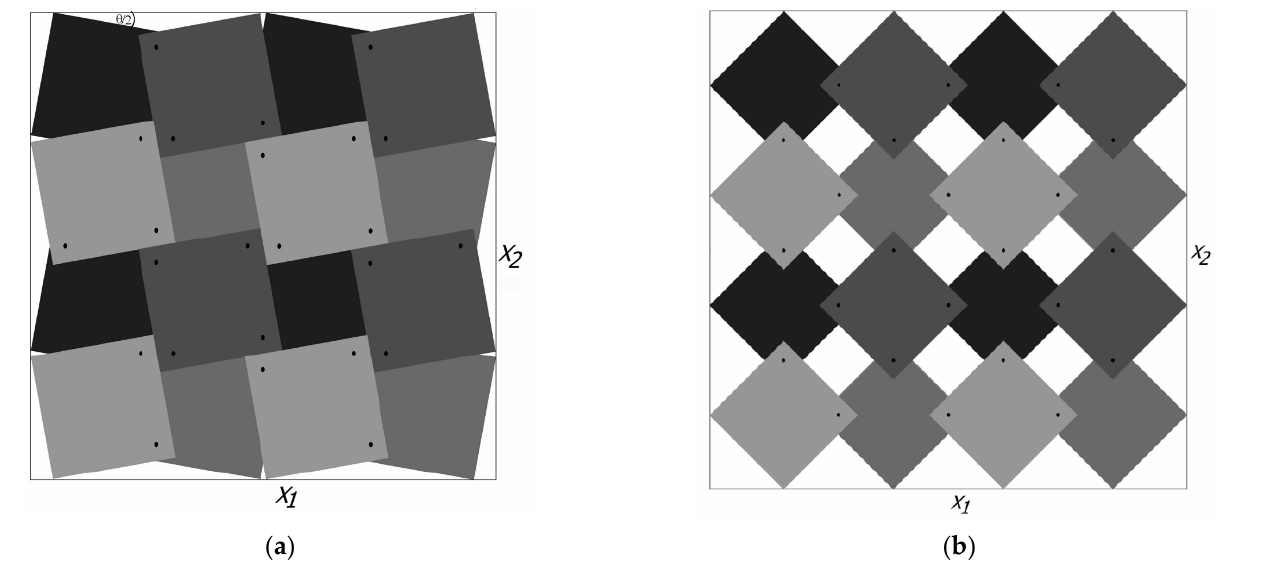
Figure 5. Auxetic structure 4 × 4 in the closed ( a ) and open ( b ) position for x = 1/7.